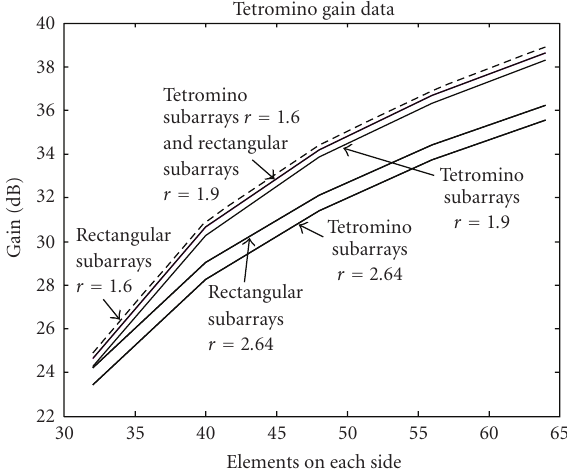
Figure 10: Sidelobe reduction factor (max rectangular subarray quantization lobe level—largest octomino sidelobe level) dB for moderate and wide band signals.